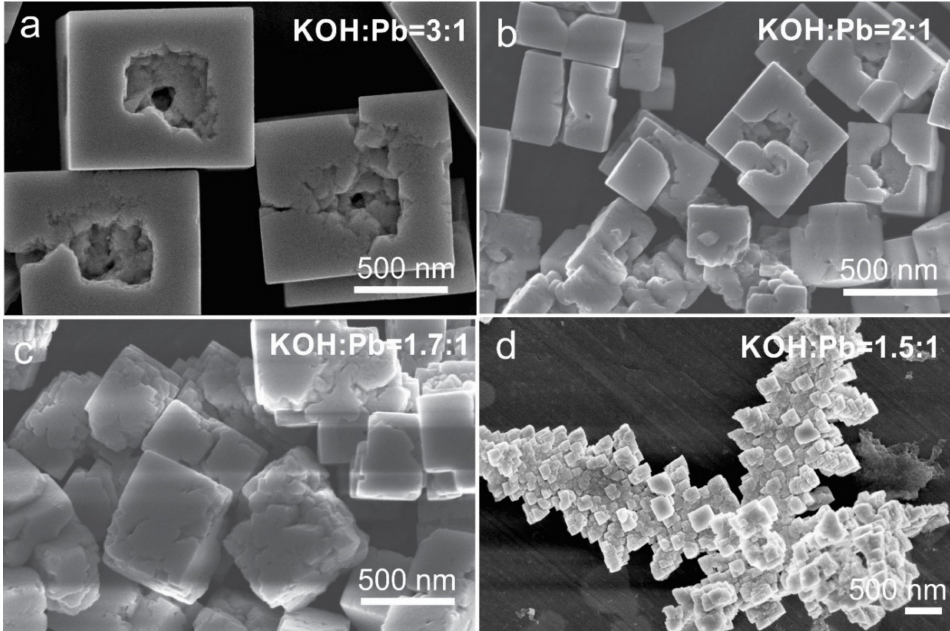
Figure 8. SEM micrographs (SE images) of the PZT08 reaction product obtained through two- step precipitation process and hydrothermal reaction at 235 ◦ C (12 h) and at ( a ) KOH:Pb = 3:1, ( b ) KOH:Pb = 2:1, ( c ) KOH:Pb = 1.7:1, and ( d ) KOH:Pb =